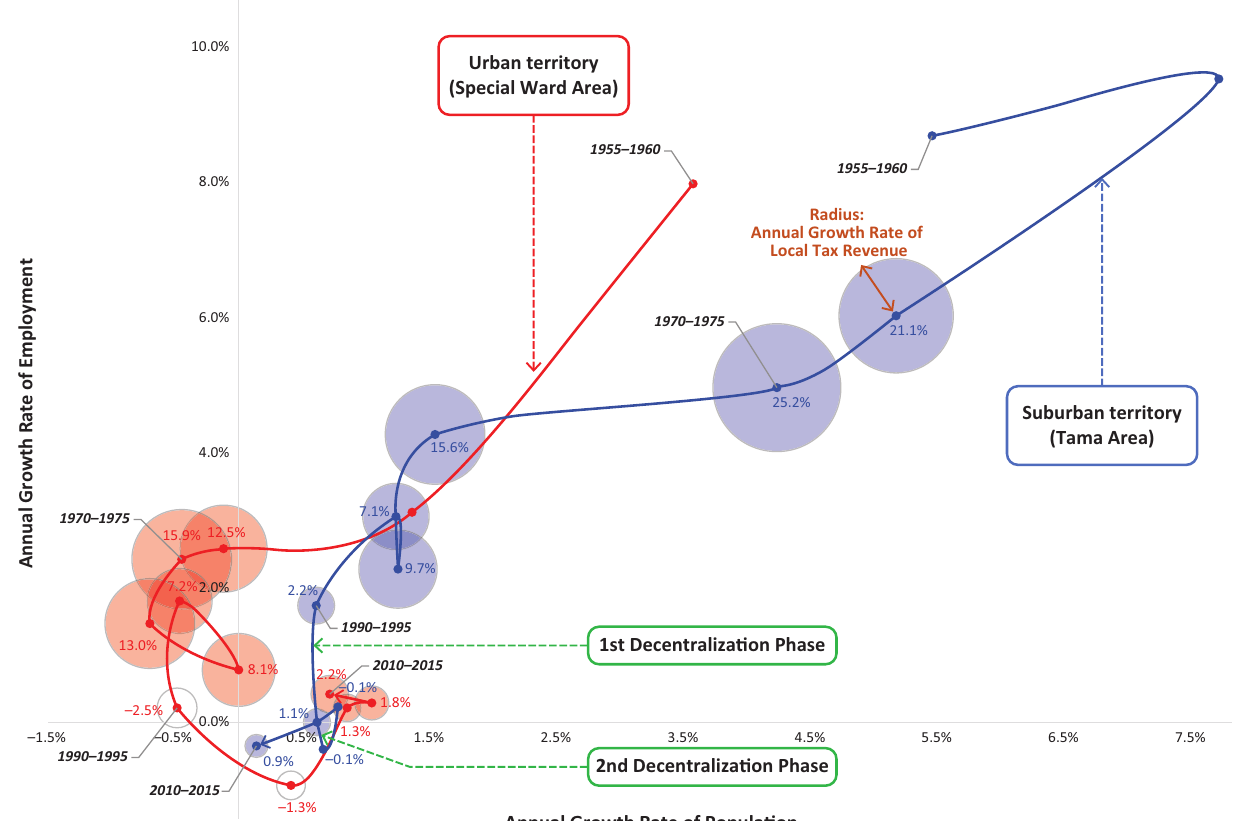
Figure 3. Tokyo’s suburban territory facing delayed decentralization and a rapid shift to recentralization. Notes: 1)